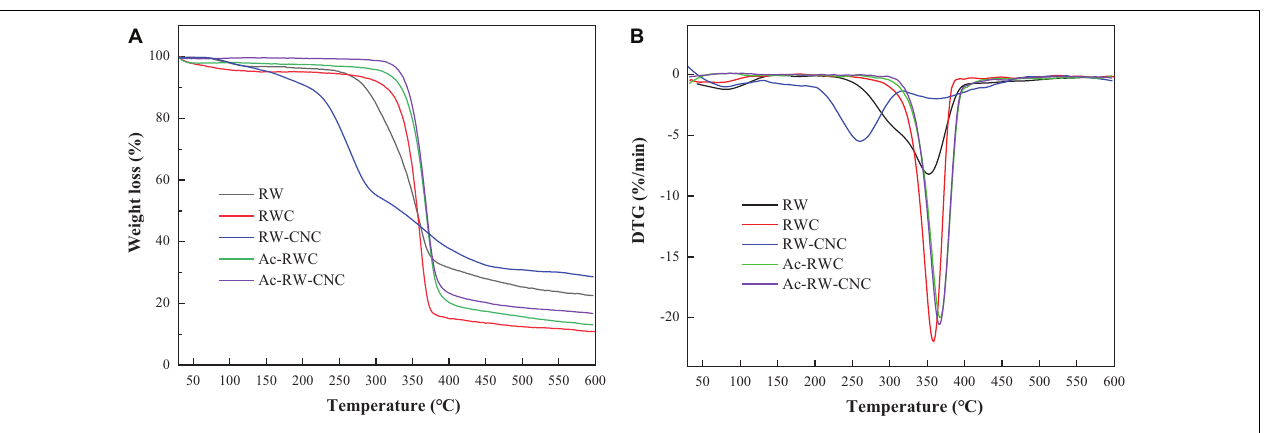
FIGURE 5 | TGA curves (A) and DTG curves (B) of different fiber-based